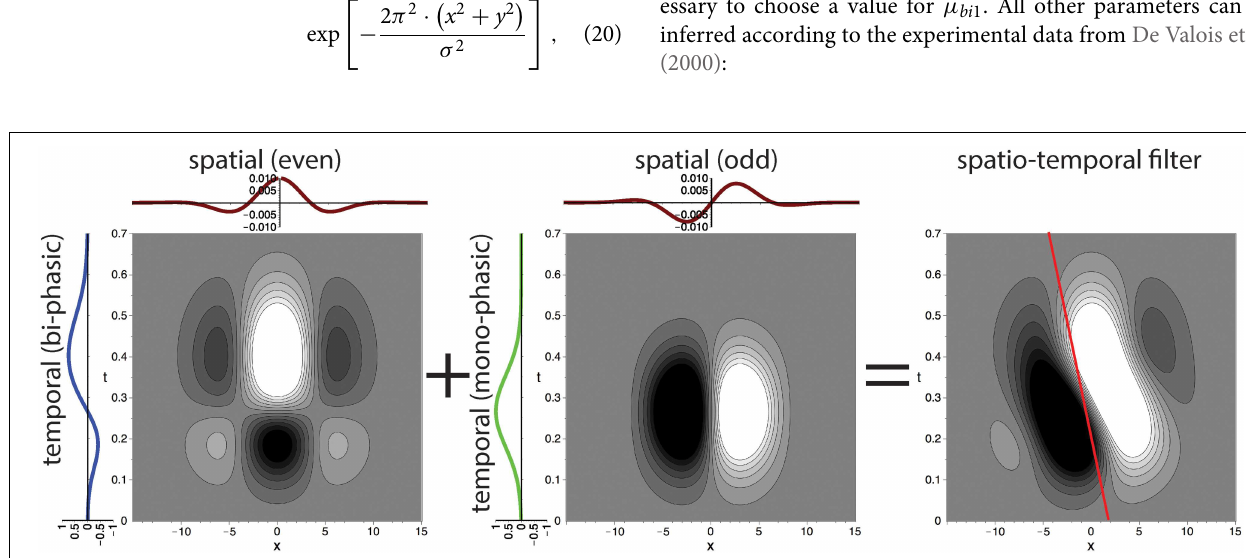
motion direction selective spatio-temporal filter. Each of the two filters is separable into a pair of a bi-phasic temporal and an even spatial or a mono-phasic temporal and an odd spatial filter, respectively (illustrated by line profile plots to the left and at the top). The red line indicates the preferred speed selectivity identified by a Fourier analysis of the filter function (c.f. Section